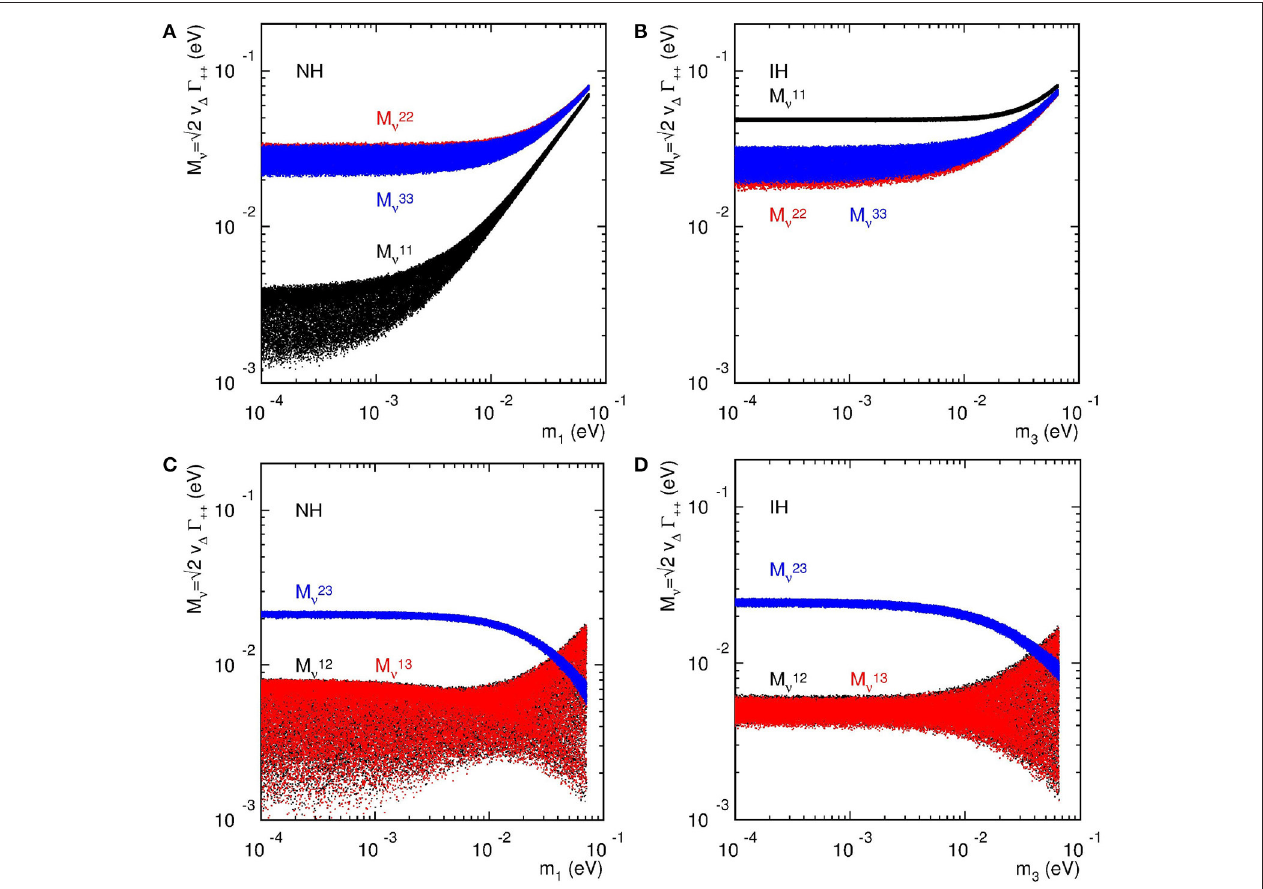
√ 2 v 1 Ŵ vs. the lowest neutrino mass for NH ≡ ++